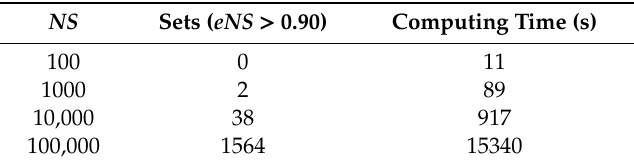
Table 2. Results for the definition of NS